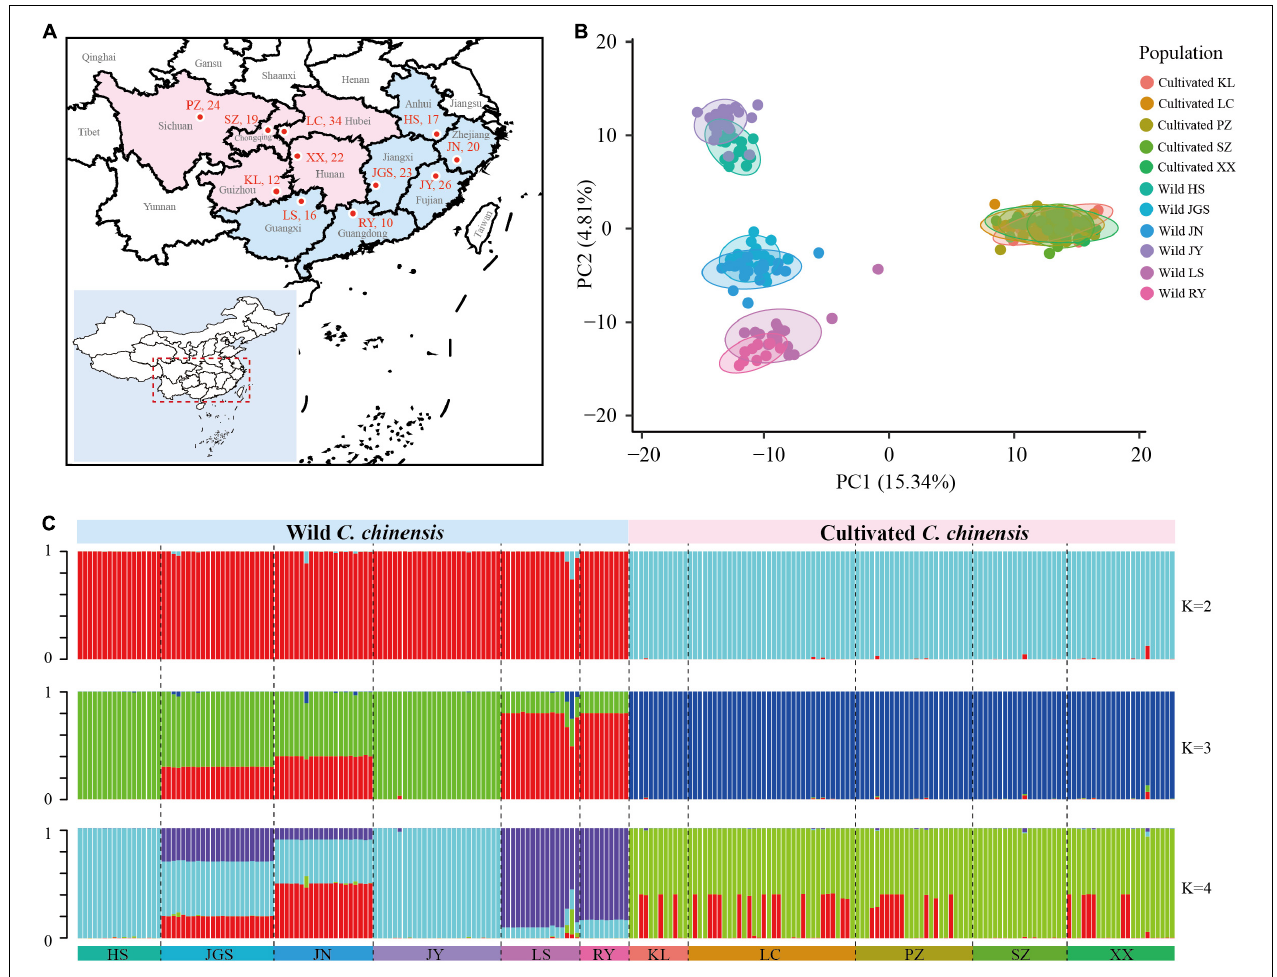
FIGURE 4 | Population structure of C. chinensis populations. (A) Geographic distribution of the sampling locations. The map plot was generated using an R package (https://github.com/linhesun/bilibiliRlearning/tree/master/2021_r21_china_map). (B) PCA of wild and cultivated populations; the proportion of the variance explained was 15.34% for PC1 and 4.81% for PC2. (C) STRUCTURE analysis for K = 2–4. Colors indicate different clusters. The x-axis shows the subpopulations, and the y-axis indicates the probability of inferred ancestral